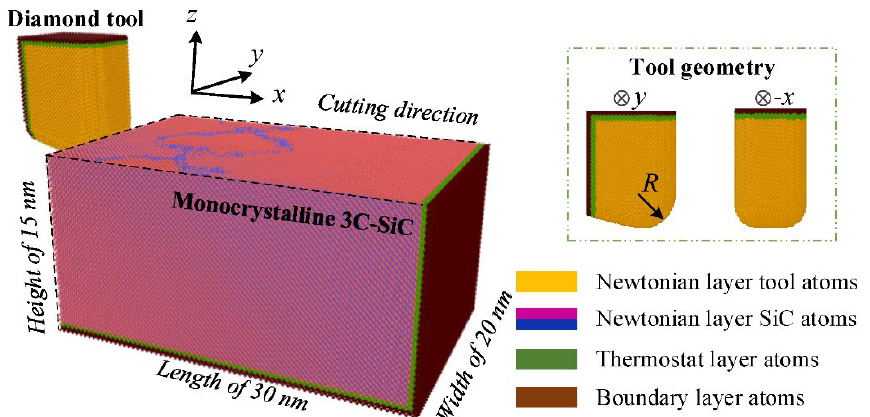
Figure 40. MD model of nanometric cutting on monocrystalline 3C-SiC [201].